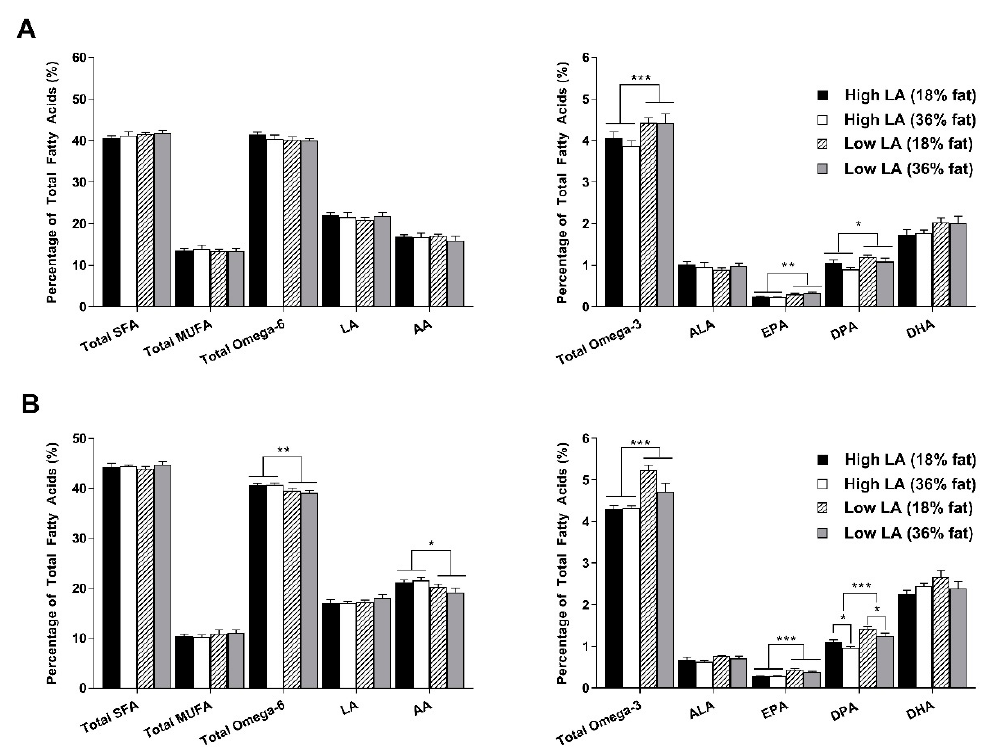
Figure 4. O ff spring whole blood fatty acid profile in ( A ) male and ( B ) female o ff spring at 8 weeks Figure 4. Offspring whole blood fatty acid profile in ( A ) male and ( B ) female offspring at 8 weeks of of age. Values are means ± SEM and n = 6–9 per group. The e ff ects of maternal dietary age. Values are means ± SEM and n = 6–9 per group. The effects of maternal dietary fatty acid ratio fatty acid ratio and maternal dietary fat content were determined using a two-way ANOVA. and maternal dietary fat content were determined using a two-way ANOVA. All comparisons were All comparisons were made within sex group. * Indicates significant di ff erence (* p < 0.05, ** p < 0.01, made within sex group. * Indicates significant difference (* p < 0.05, ** p < 0.01, *** p < 0.001). SFA, *** p < 0.001). SFA, saturated fatty acid; MUFA, monounsaturated fatty acid; LA, linoleic acid; saturated fatty acid; MUFA, monounsaturated fatty acid; LA, linoleic acid; AA, arachidonic acid; AA, arachidonic acid; ALA, alpha-linolenic acid; EPA, eicosapentaenoic acid; DPA, docosapentaenoic ALA, alpha-linolenic acid; EPA, eicosapentaenoic acid; DPA, docosapentaenoic acid; DHA, acid; DHA, docosahexaenoic docosahexaenoic acid.